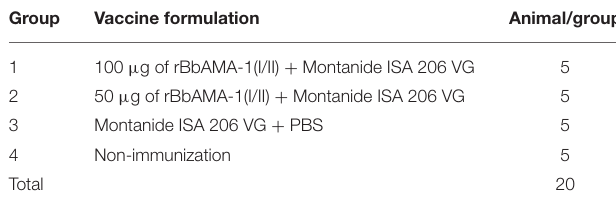
TABLE 1 | Vaccine immunization in cattle. Group Vaccine